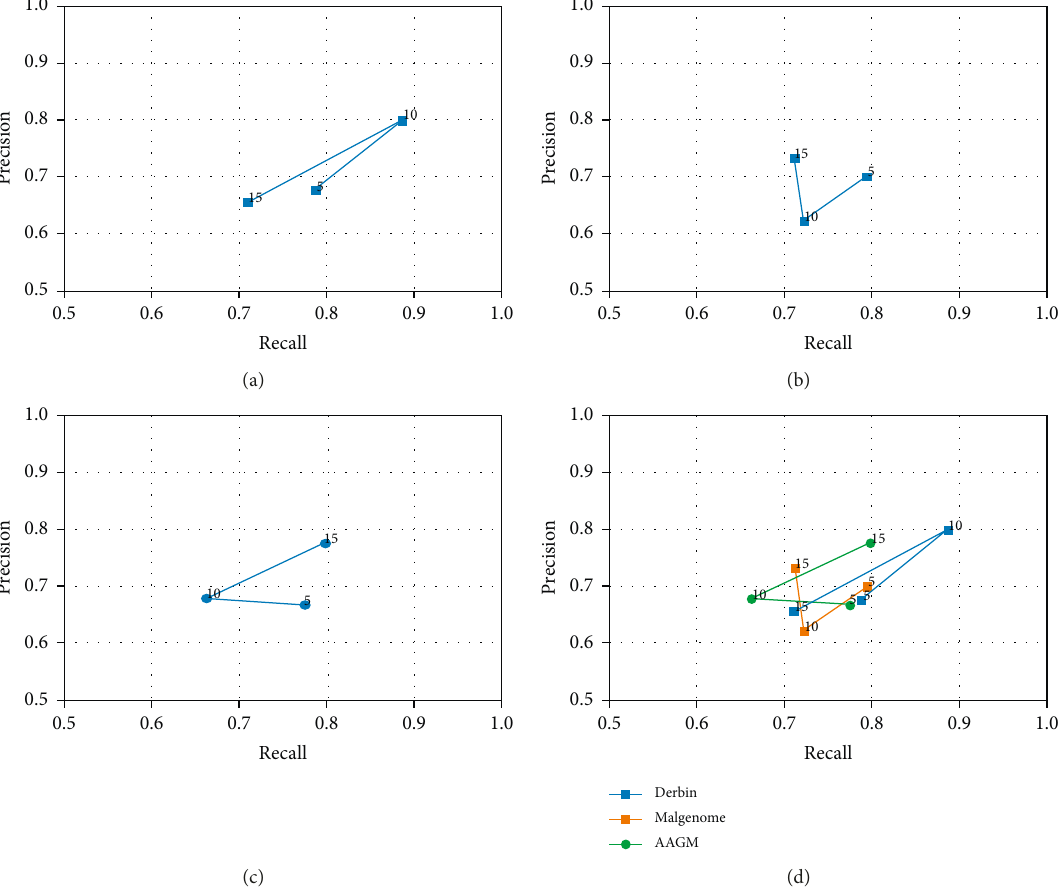
Figure 19: P-R curves according to topic words. (a) Drebin dataset. (b) Malgenome dataset. (c) AAGM dataset. (d) Performance